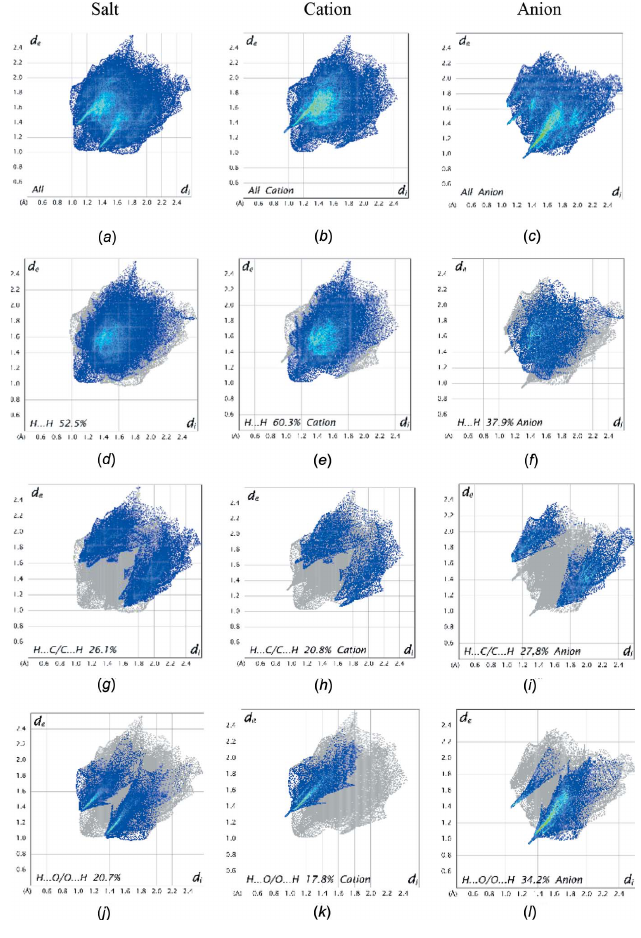
Figure 8 Full two-dimensional fingerprint plots for the salt ( a ), cation ( b ) and anion ( c ) together with ( d )–( l ) separate principal contact types for the salt, cation and anion systems respectively. These are found to be H (cid:2)(cid:2)(cid:2) H, H (cid:2)(cid:2)(cid:2) C/C (cid:2)(cid:2)(cid:2) H, and H (cid:2)(cid:2)(cid:2) O/O (cid:2)(cid:2)(cid:2) H